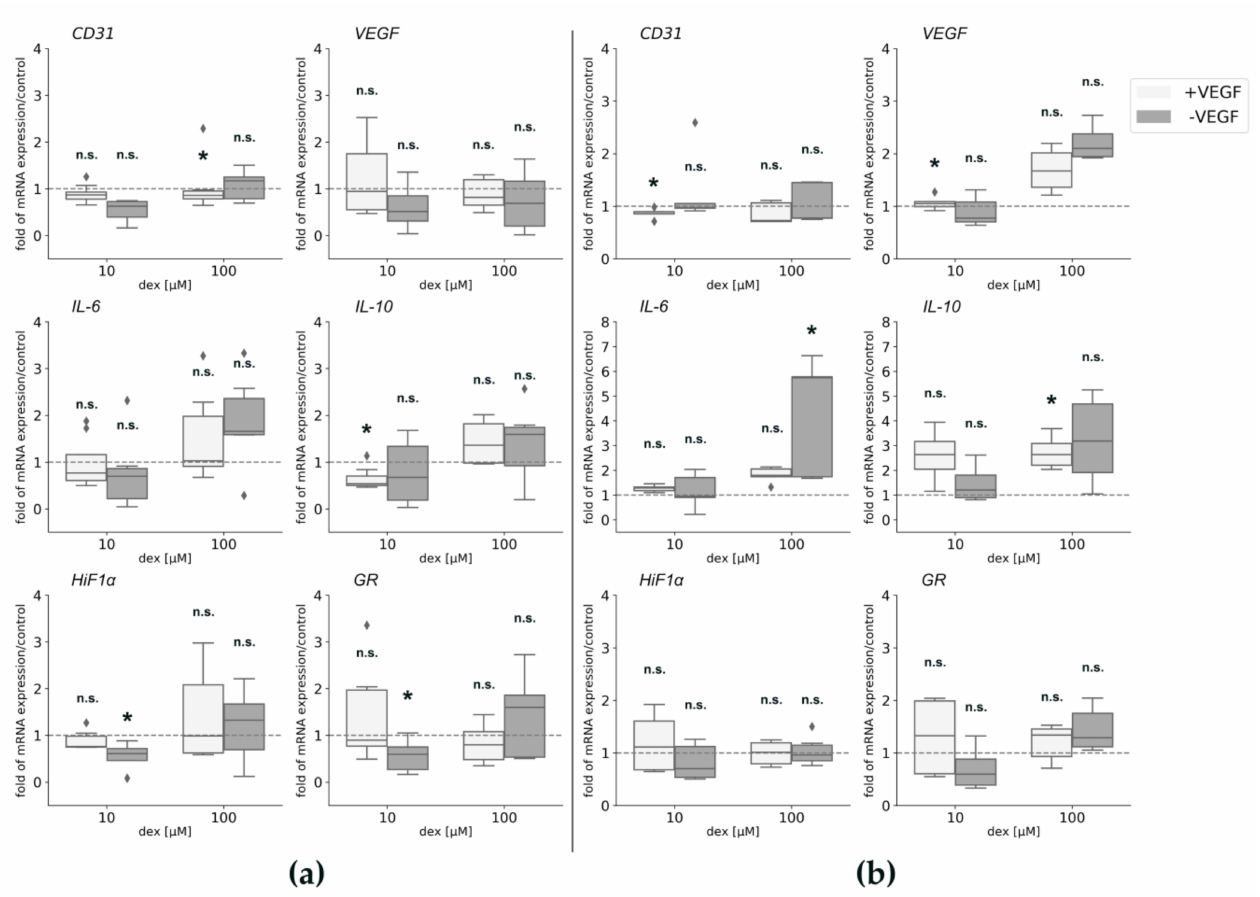
Figure 3. Gene expression analyses for CD31 , VEGF , IL-6 , IL-10 , HiF1 α , and GR of HUVECs in HM1 medium (with VEGF) or in HM1-V medium (without VEGF) and 10 and 100 µ M dex for 24 h. HUVECs were seeded in Matrigel ( a ) or on plastic culture plates ( b ). The mRNA levels were normalized to GAPDH and calculated as ratios in relation to the untreated control group (interrupted line). Results are presented as medians and quartiles ( n = 3), and p values < 0.05 indicate statistical significance (* p < 0.05), n.s. = non-significant. Outliners are presented as